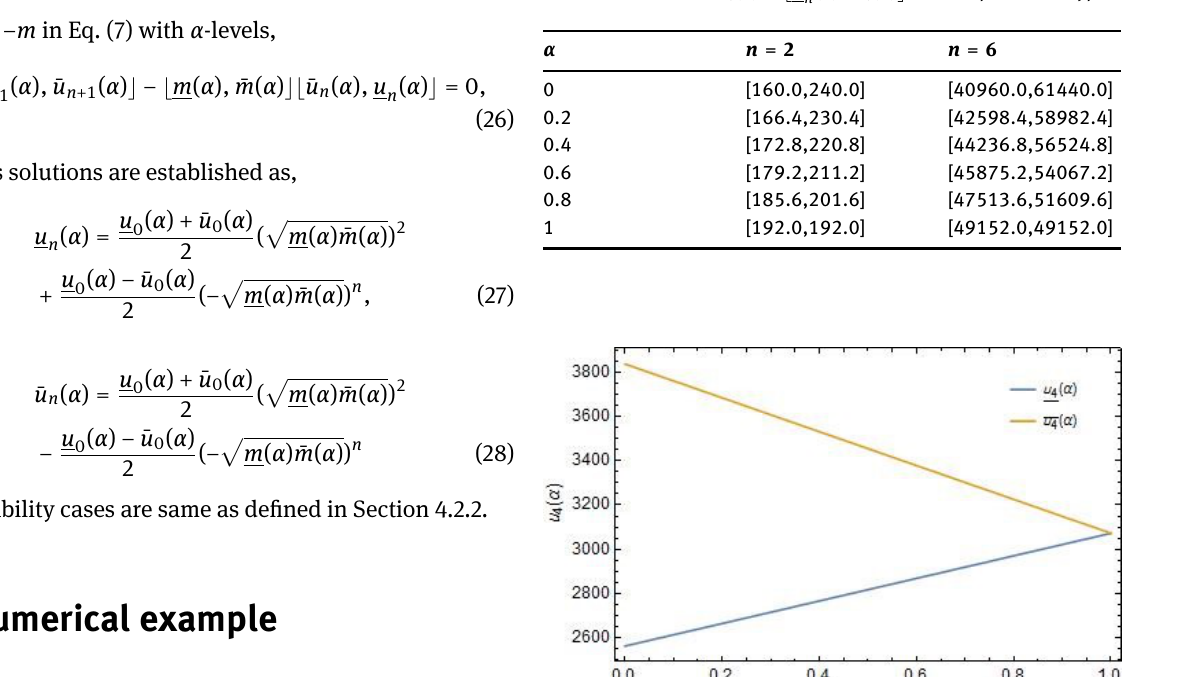
Table 1: Solution of u n ( α ) = ⌊ u n ( α ), ¯ u n ( α ) ⌋ of Example 5.1 for Type I